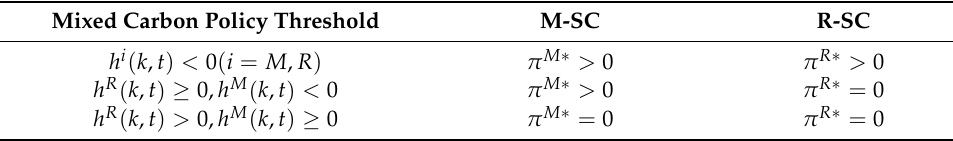
Table 2. Profit changes of different types of